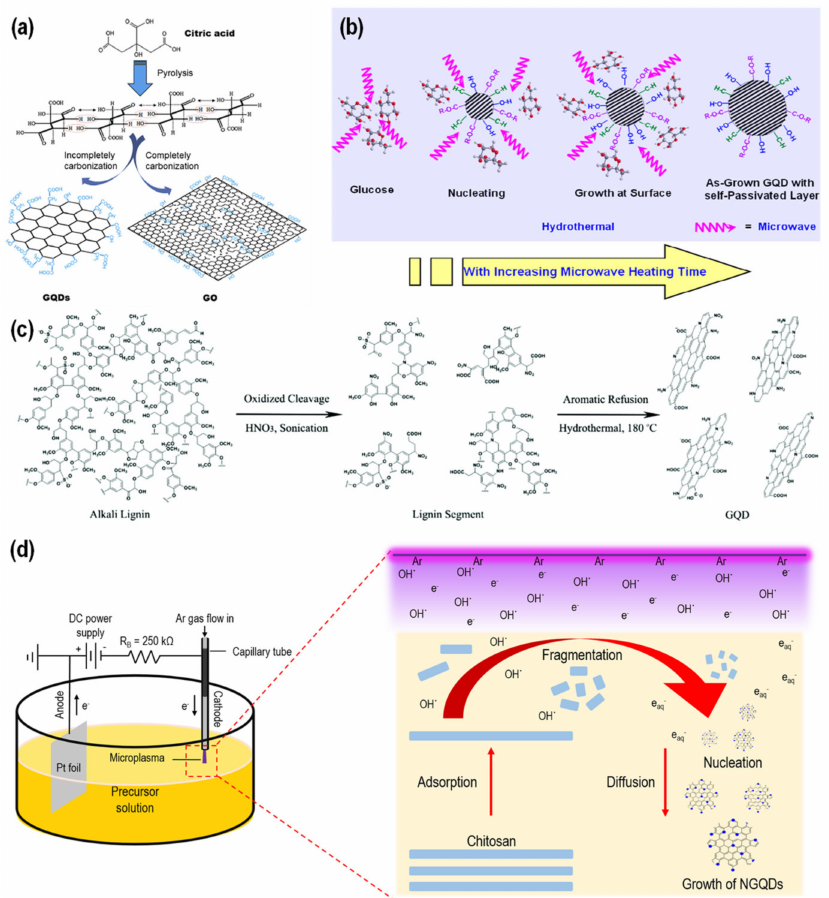
Figure 4. Synthesis of GQDs based on bottom–up approach using natural resources. GQDs synthesis from ( a ) citric acid [52], ( b ) glucose [53], ( c ) lignin [54], and ( d ) chitosan